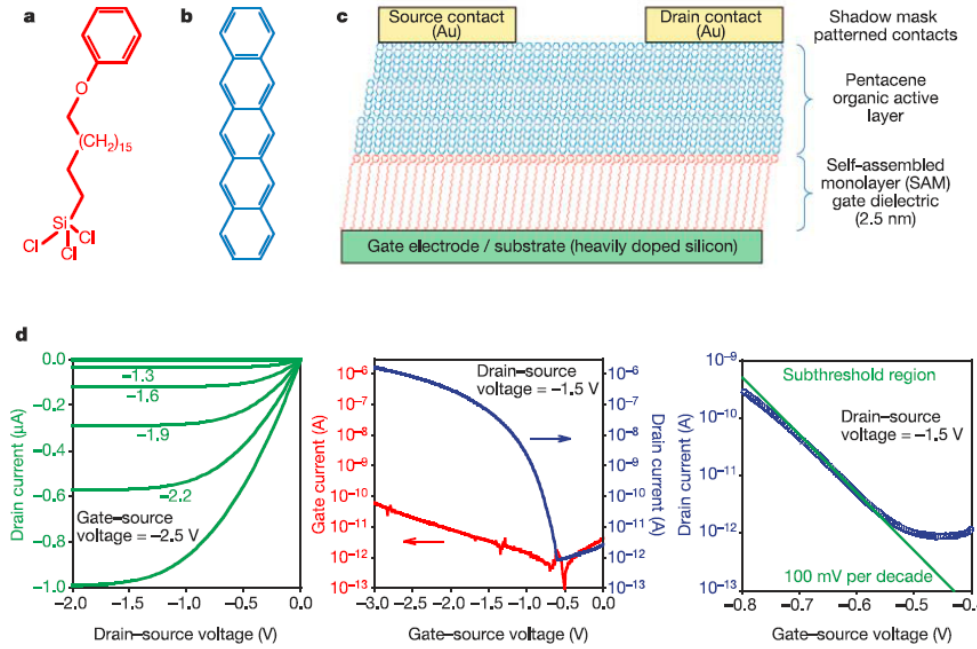
Figure 3. Structure and electrical characteristics of a molecular FET. ( a ) Structure of (18-phenoxyoctadecyl)trichlorosilane (PhO-OTS); ( b ) structure of the organic semiconductor pentacene; ( c ) cross-section of a pentacene organic field-effect transistor (OFET); ( d ) output and transfer characteristics, with subthreshold region showing a subthreshold swing of 100 mV per decade [31]. Reproduced with permission from [31], © Nature Publishing Group, 2004.